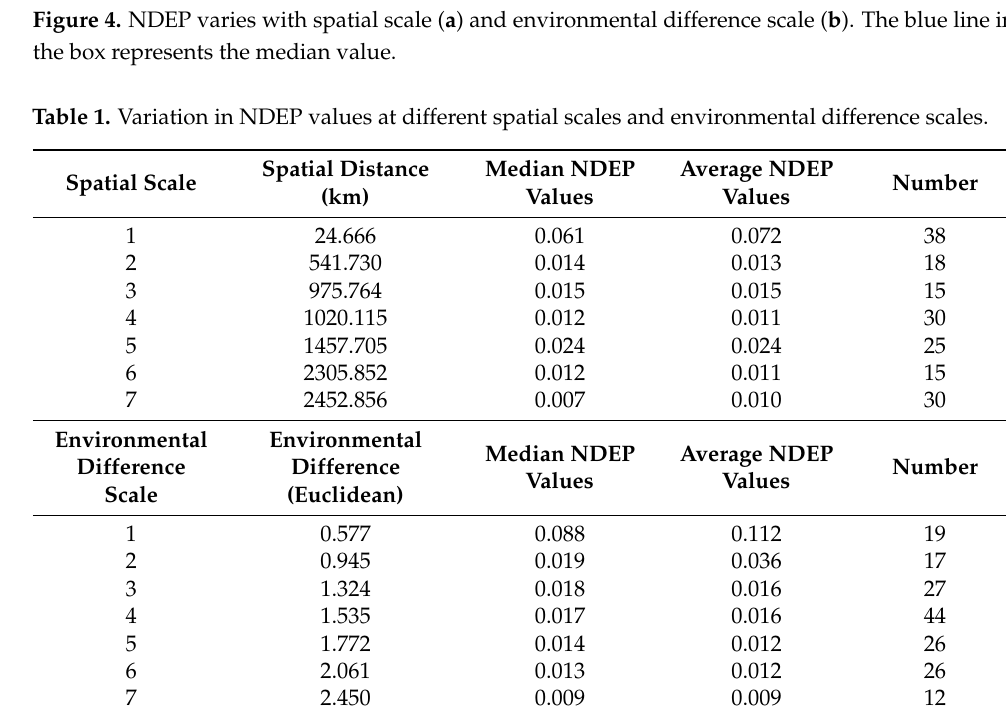
Figure 5. The contribution of spatial distance and environmental difference to NDEP based on Var ‐ iance Partitioning Analysis. The left yellow circle represents spatial distance, and the right green circle represents environmental difference.